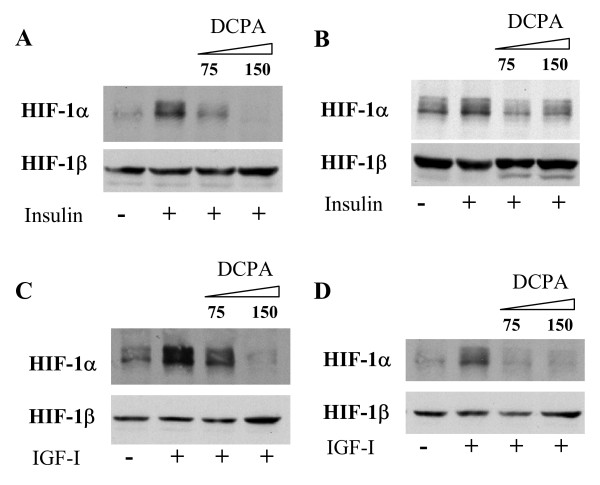
DCPA specifically inhibits expression of HIF-1α induced by insulin and IGF-I. DU145 (A) and PC-3 (B) cells were cultured in the basal medium without serum in the presence of 0, 75 or 150 μM DCPA for 24 h, followed by the incubation with (+) or without (-) 200 nM insulin for 6 h. The total cellular proteins were prepared from the cells, and used for the analysis of HIF-1α and HIF-1β protein expression as described above. DU145 (C) and PC-3 (D) cells were cultured in the basal medium without serum as above, followed by the incubation in the presence (+) or absence (-) of 2 nM IGF-I for 6 h. The HIF-1α and HIF-1β protein expression from the cells was analyzed by immunoblotting.